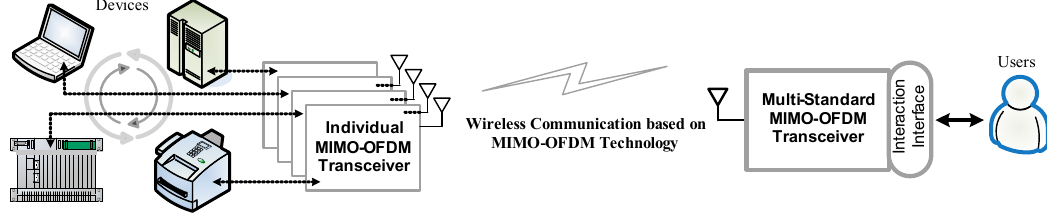
Figure 1. Scheme illustration of multistandard multiple-input, multiple-output orthogonal frequency-division multiplexing (MIMO-OFDM) data access applications.